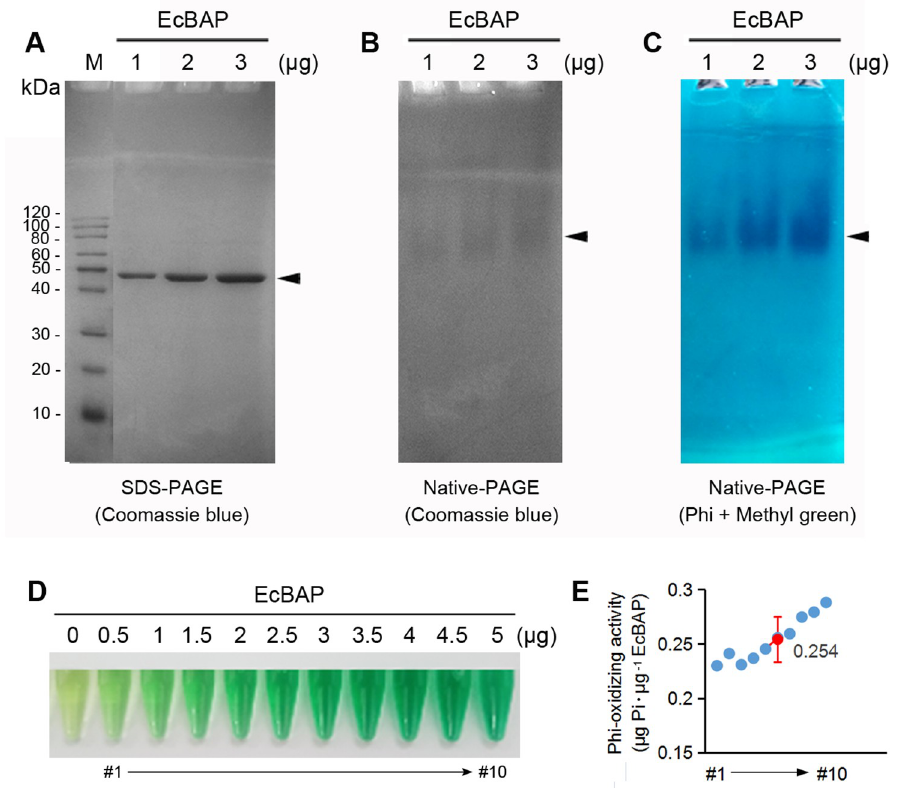
Fig 2. The recombinant EcBAP has an apparent Phi-oxidizing activity in vitro . (A) The recombinant EcBAP was analyzed by SDS-PAGE and coomassie blue staining for purity assessment; (B) The recombinant EcBAP at the non- denatured status was visualized by native-PAGE and coomassie blue staining; (C) The Phi-oxidizing activity of recombinant EcBAP was qualitatively evaluated by native-PAGE gel activity staining in a consecutive reactant system composed of Phi and methyl green; (D) Ten individual reactions (#1–#10) were conducted for Pi/AM/MG-based spectrometric assay to quantitatively determine the Phi-oxidizing activity of recombinant EcBAP, and (E) The calculated Phi-oxidizing activity ( μ g Pi � μ g -1 EcBAP) of all ten reactions were shown together, with the mean ( ± SD) marked in red (also see S2 File). Arrow-head indicates the recombinant EcBAP protein. The original gel images for this figure (A–C) are available in S1